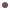
Correlation between overflow metabolism and Mean Square Error (MSE).(A), (B), and (C) show S. cerevisaie’s MSE between observed and predicted inner metabolic fluxes. MinFlux and Geometric predictions outperform MaxEnt when the level of overflow metabolism is below 0.5 but thereafter the situation inverts, suggesting that the minimization of fluxes assumption of MinFlux and Geometric may not be universally suitable. (D), (E), and (F) show a similar trend in E. coli. MinFlux and Geometric predictions have lower MSE than MaxEnt at low levels of overflow metabolism, but their MSE shows a positive Pearson correlation, r, at higher levels of overflow metabolism. On the other hand, MaxEnt shows a close to zero correlation with the level of overflow metabolism in both species. * indicates statistically significant Pearson correlation values (p-value ≤ 0.005). Data points are color coded as • MaxEnt, • Geometric, and • MinFlux. Δ correspond to mutated strains overproducing acetate.